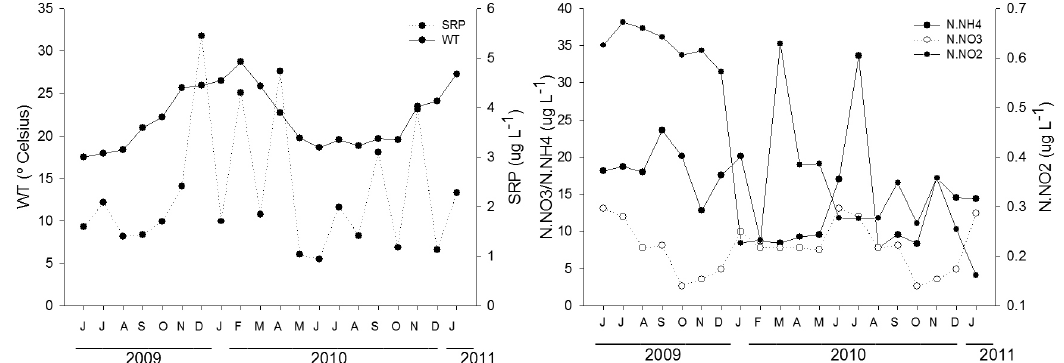
Figure 4. Monthly variations of water temperature (WT), soluble reactive phosphorus (SRP) and forms of dissolved inorganic nitrogen (N.NO2, N.NO3 and N.NH4) during sampling in the Peri Lake, from June/2009 to density during the study period, and together with Actinastrum aciculare, presented the highest densities in this month.